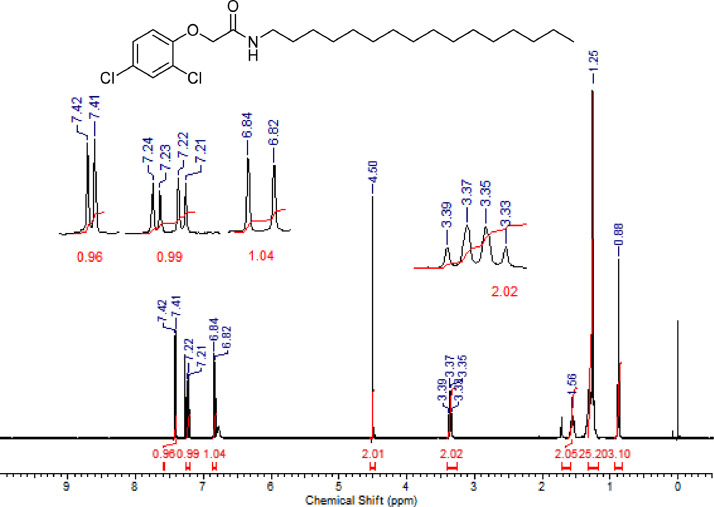
1H NMR (CDCl3, 400 MHz) spectrum of compound 8a.